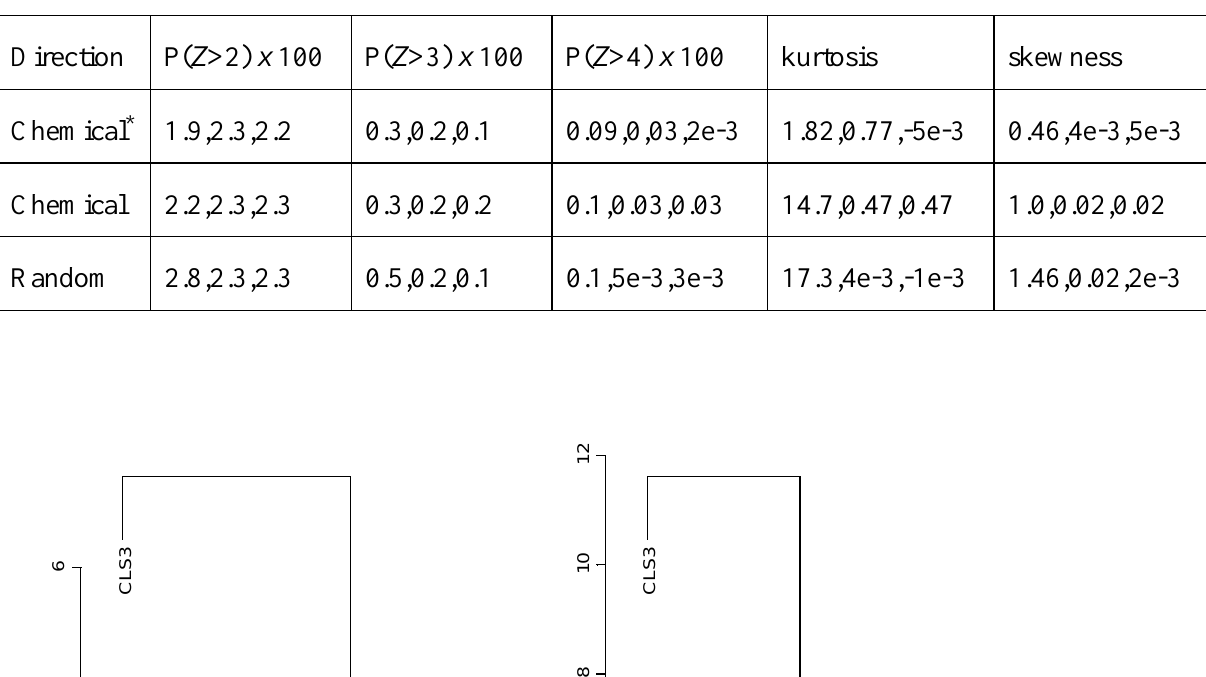
Table 3. Results summary (averages over the results for 2 chemicals for multiple cases) for the distribution of each entry in the ˆ β vector. Cell entries are CLS, GLS, and G values, where G refers to GLS results from the reference Gaussian. The Chemical * directions case is chemicals chosen from distinct chemical groups rather than completely at random from the 296-chemical library.